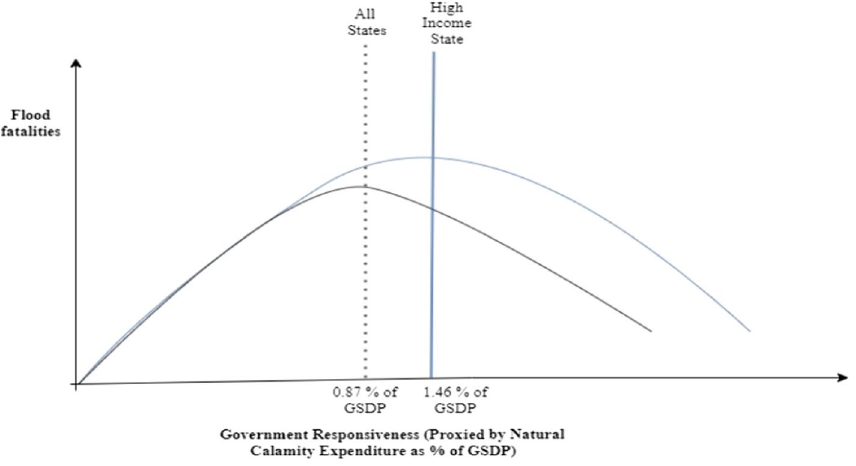
Figure 3. Turning point for flood fatalities with Government responsiveness—all states, high-income, and low- income